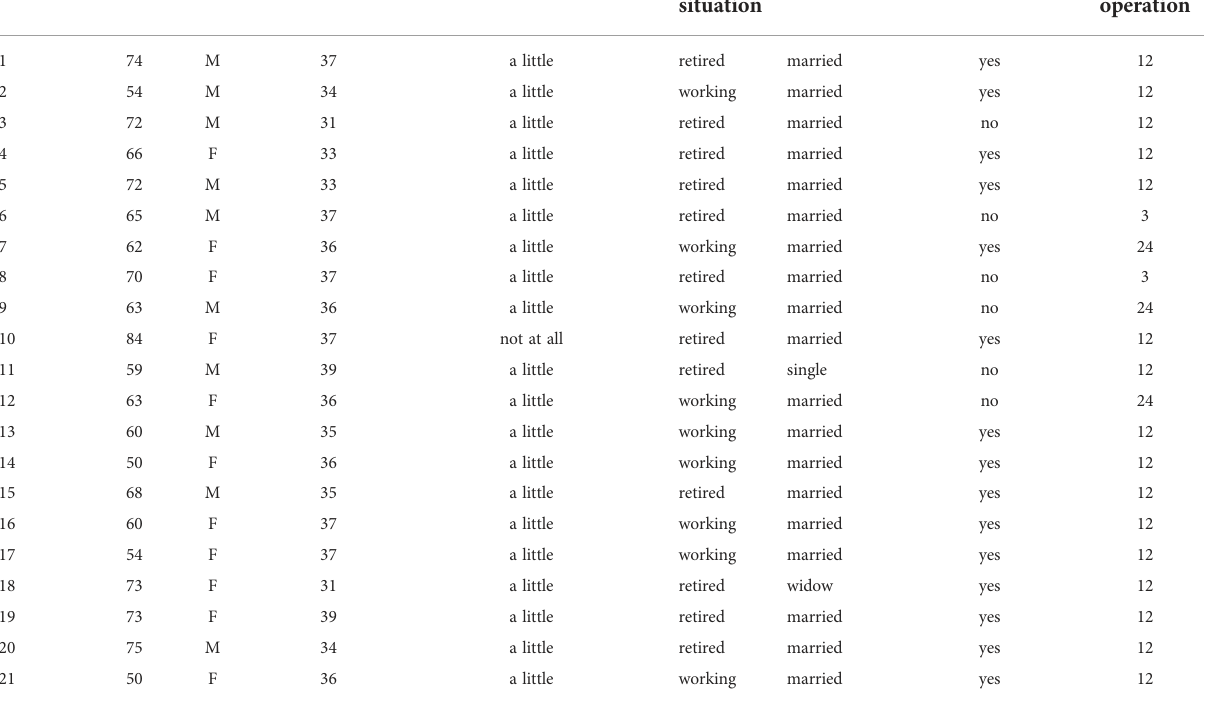
TABLE 1 Patient